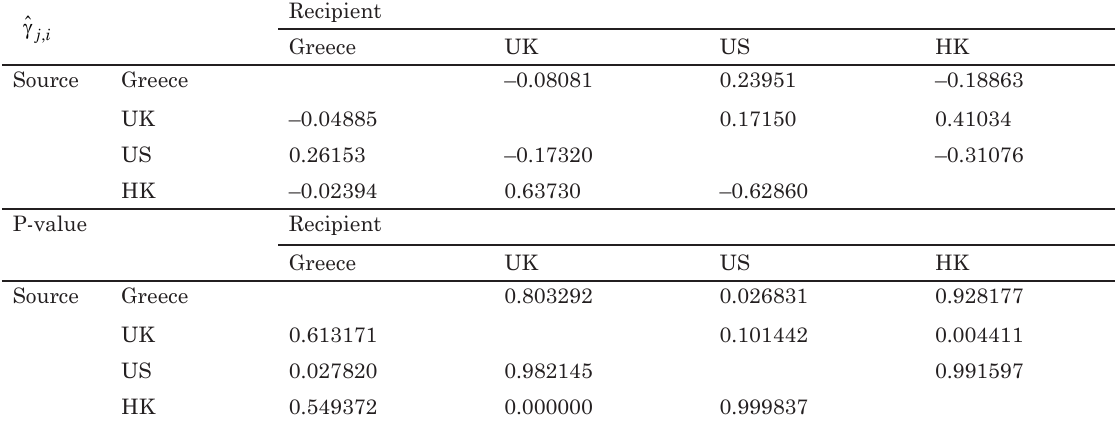
Table 4. The result of the FRM test on the equity markets